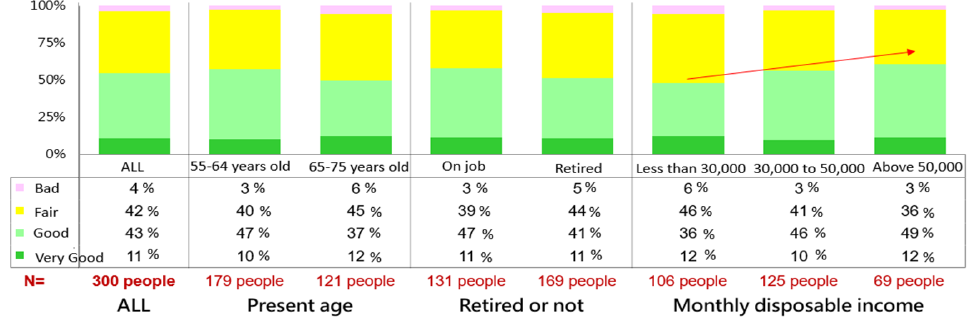
Figure 1. The self-health situation of those aged 55–75 years.